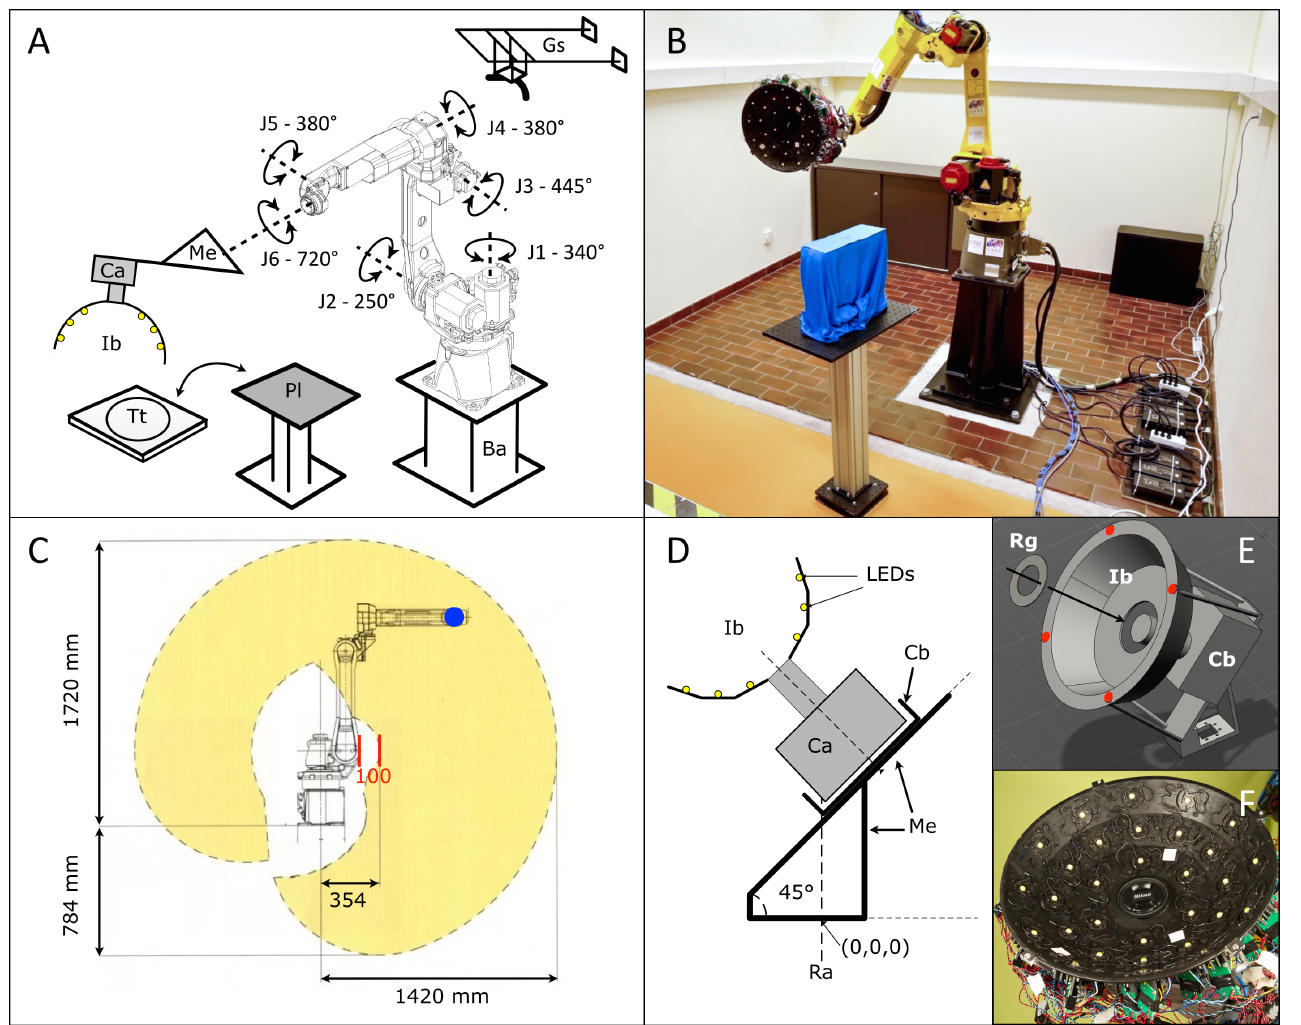
Fig 1. The R 2 OBBIE scanning system. A) Schematic representation of the set up; J1 – J6 , the six axes of the robot; Ba , elevated base; Me , mechanical extension; Ca , camera; Ib , illumination basket; Pl , platform for positioning the target object; Tt , turn-table; Gs , gutter to suspend objects. B) R 2 OBBIE with the platform configuration. C) The working envelope (yellow) of the robot J5 axis (blue) in the vertical plane passing by J1. D) Schematic view of the camera (Ca) fixed in the camera box (Cb), the illumination basket (Ib), and the mechanical extension; Ra, Rotation axis of J6. E) The illumination basket is fixed to the camera with a ring (Rg) and by four points (red) to the camera box through cylindrical rods. F) Picture of the illumination basket showing the 30 LEDs in